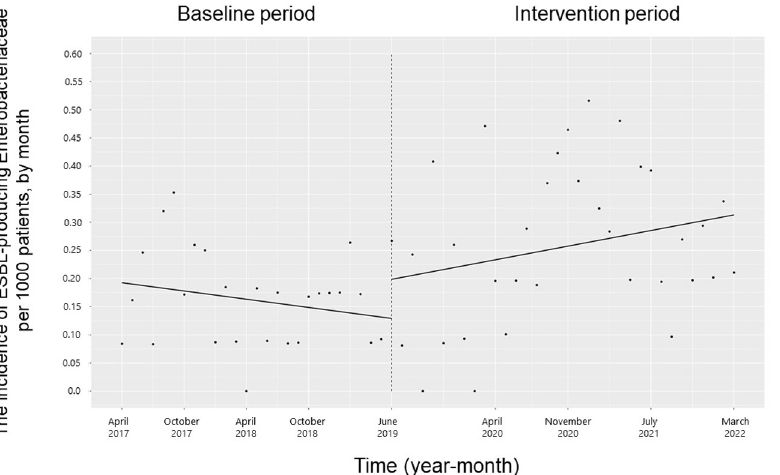
refers to ESBL-producing Enterobacteriaceae per 1000 patients in each month; the slope is based on linear regression in the four phases: Phase 1 (pre-intervention period from April 1, 2017, to May 31, 2019); Phase 2 (review of clinical pathways from June 1, 2019, to March 31, 2020); Phase 3 (establishing an infectious disease (ID) consultation service and implementing the antimicrobial stewardship program from April 1, 2020, to June 30, 2021); and Phase 4 (educational lecture and pop-up displays for oral antimicrobials from July 1, 2021, to March 31, 2022).